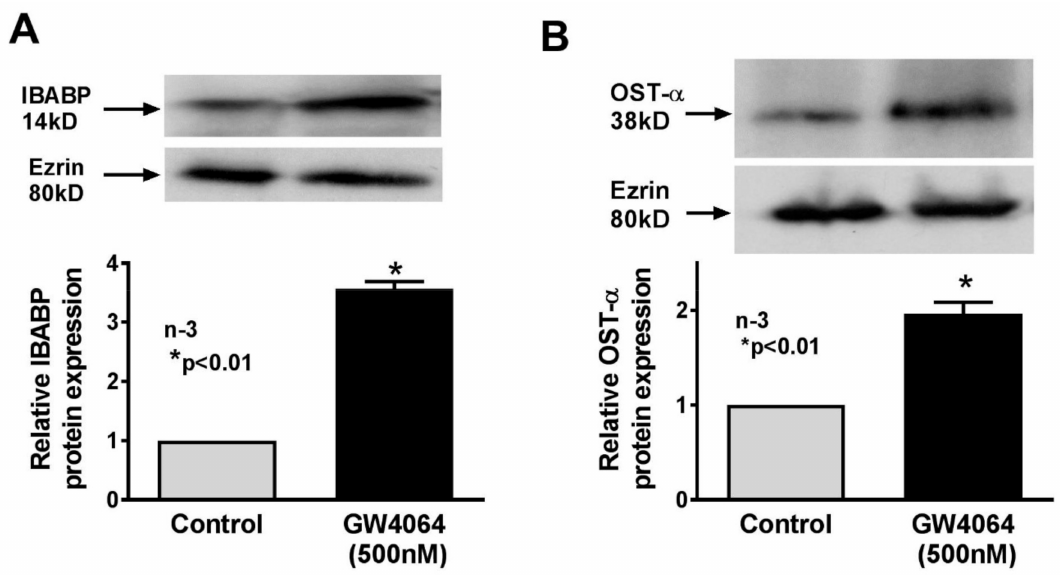
Figure 8. E ff ect of FXR agonist on bile-acid-handling protein expression in IEC-18 cells in vitro. ( A ) FXR agonist significantly increased IBABP expression in IEC-18 cells. ( B ) FXR agonist significantly increased OST α expression in IEC-18